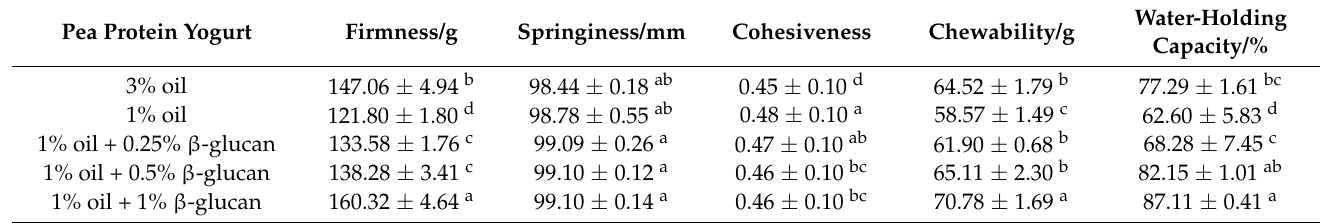
Table 1. Effects of β -glucan concentration on texture properties and water holding capacity of low-fat pea-protein-based yogurt.